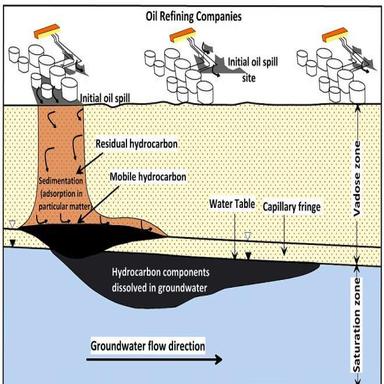
Oil spill subsurface pattern at coastal zones (modified after.